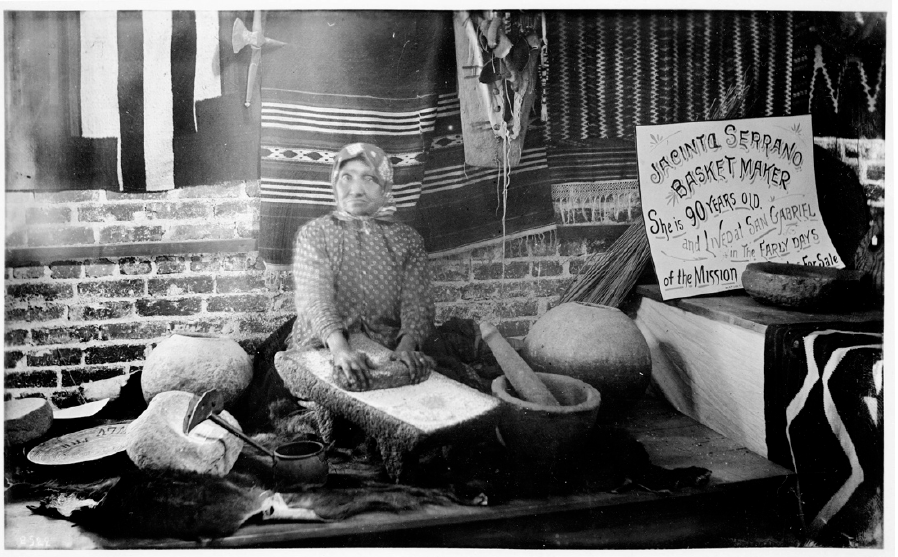
Figure 3. “Jacinta Serrano, last San Gabriel Mission Indian basket maker”, C. C. Pierce (1861–1946),